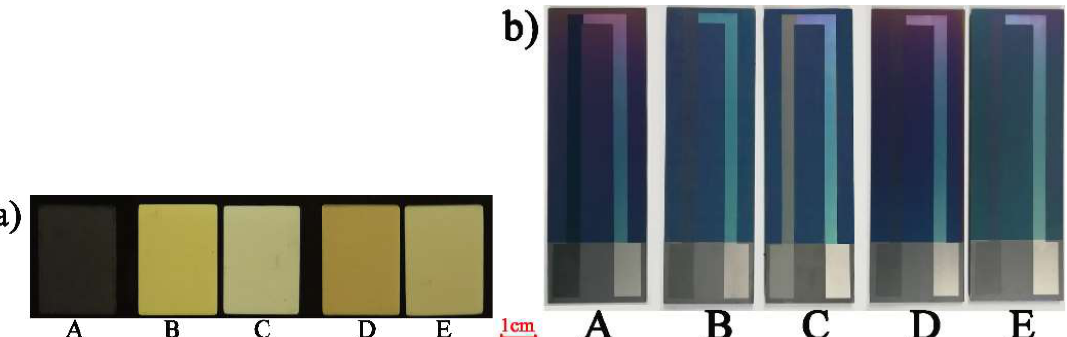
Figure 5. ( a ) Prepared In 2 O 3 thin film samples at different annealing processes. ( b ) Prepared TFTCs under different annealing processes. (A: No annealing. B: 600 °Cin air for 2 h. C: 1000 °C in air for 2 h. D: 600 °C in vacuum for 2 h. E: 1000 °C in vacuum for 2 h.).